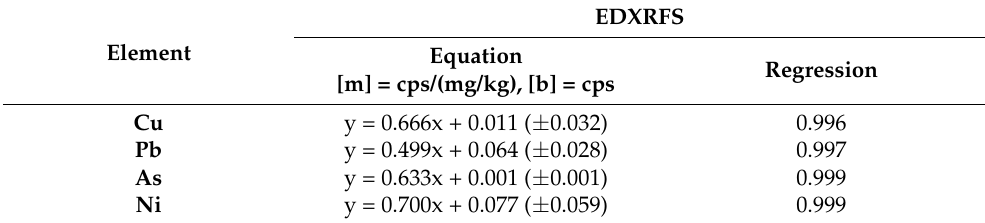
Table 1. Properties of calibration graphs.